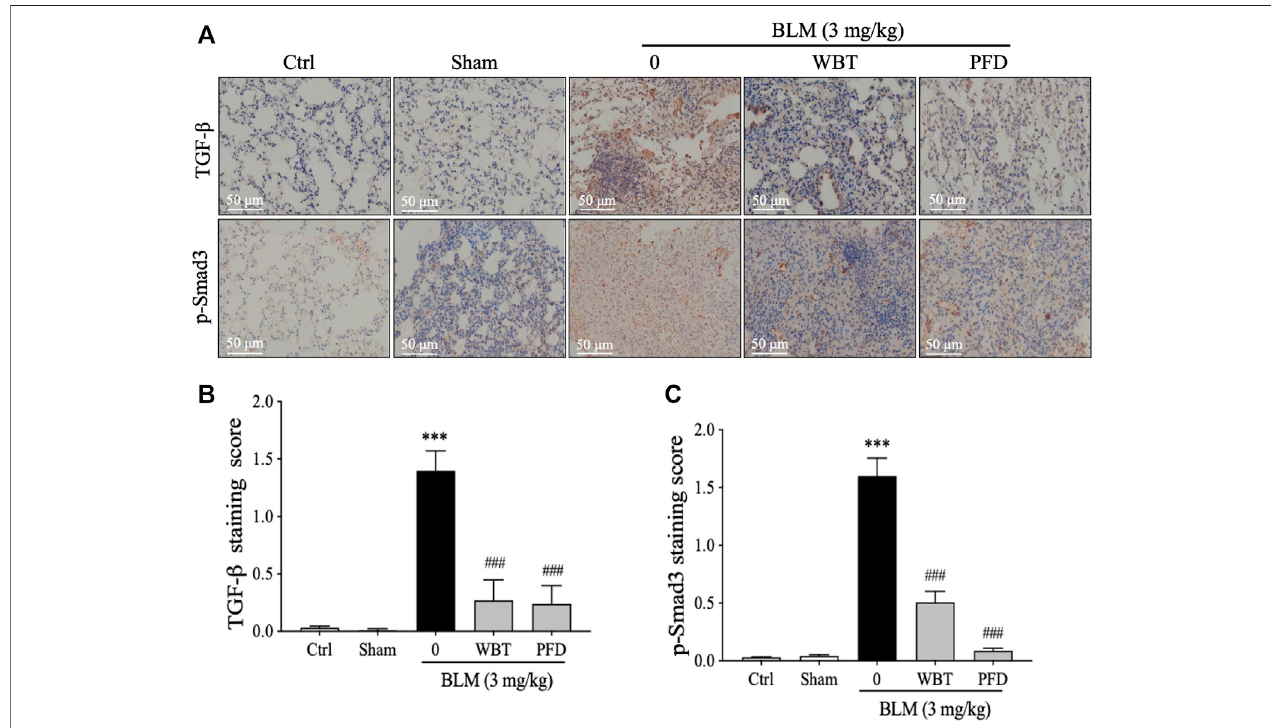
FIGURE6| TheWBTformulainhibitedtheTGF- β /Smad3pathwayintheBLM-inducedmousemodeloflung fi brosis. (A) Immunohistochemicalassaywasusedto detect the expression of TGF- β 1 and p-Smad3 in the lungs from different groups of control, sham, model, and treatment. Scale bar (cid:1) 50 μ m. (B,C) Quanti fi cation of relative TGF- β 1 and p-Smad3 levels from (A) was analyzed (n (cid:1) 5); *** p < 0.001, compared to the sham group; ### p < 0.001, compared to the BLM group. BLM, bleomycin; Ctrl, control; WBT, Wenfei Buqi Tongluo formula; PFD, pirfenidone.